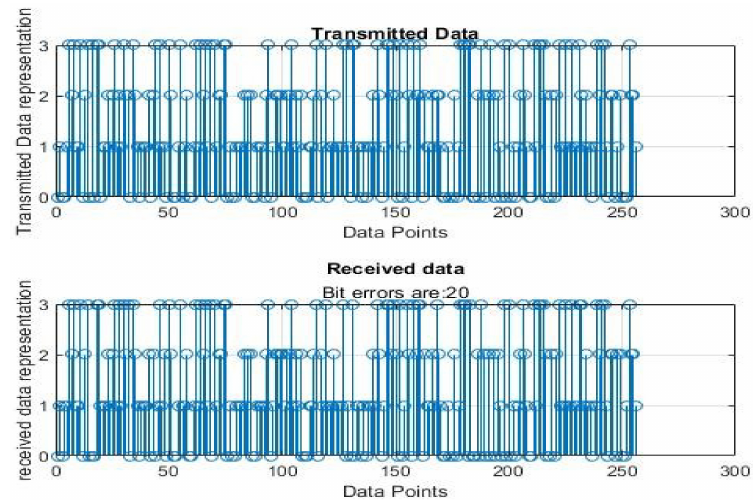
Figure 7. Customary QPSK output for 256 data points in a noiseless channel.